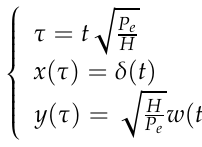
Figure 16. Identification of unknown parameters ˆ a and